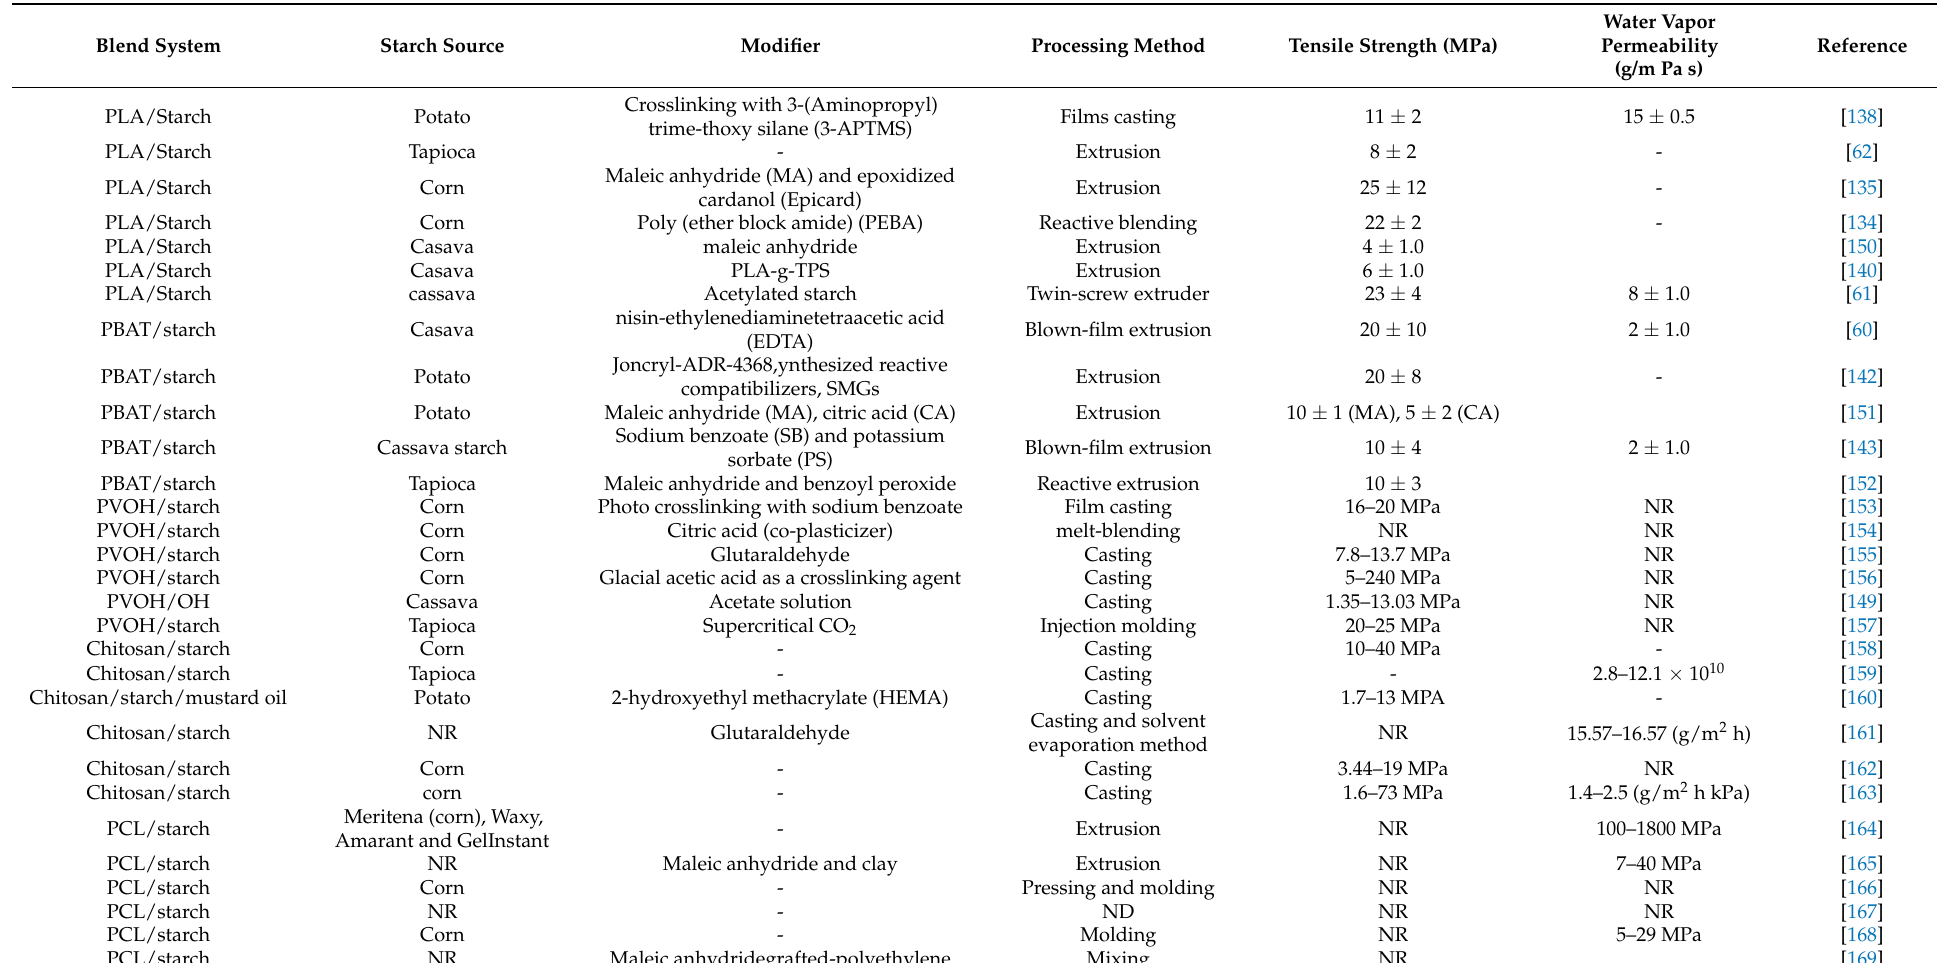
Table 4. Blend system and characteristics of starch-based